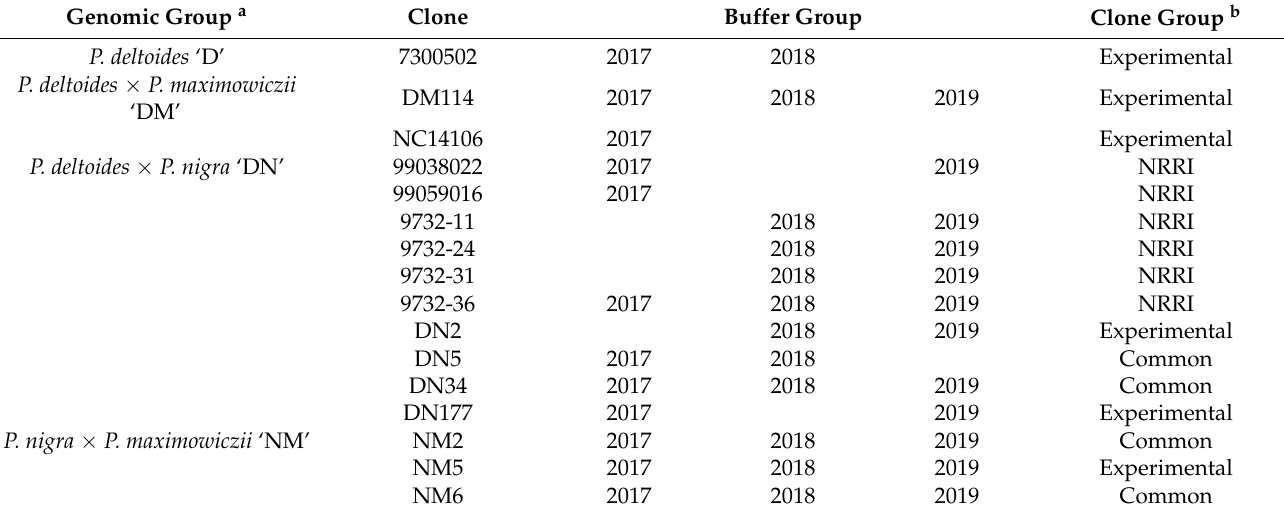
Table 3. Genomic groups, clones, buffer groups (i.e., years of planting), and clone groups for Populus genotypes tested in a regional phyto technologies network of sixteen phytoremediation buffer systems (i.e., phyto buffers) established from 2017 to 2019 in the Lake Superior watershed of the Upper Peninsula of Michigan, USA and the Lake Michigan watershed of eastern Wisconsin,